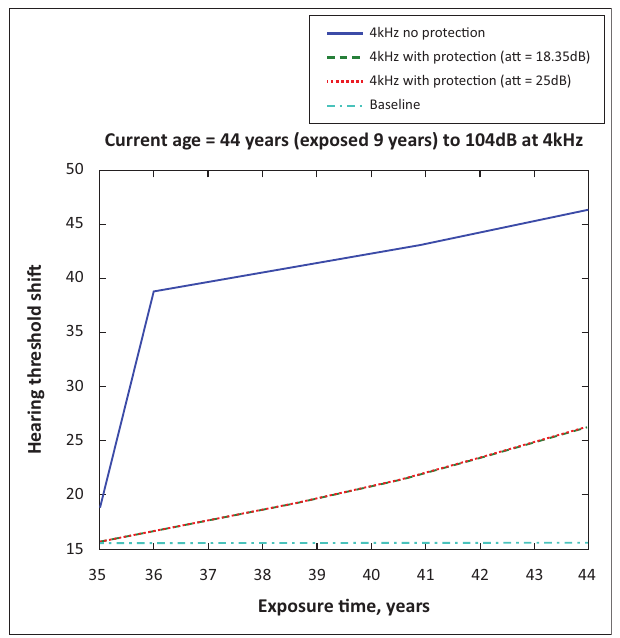
Source : Figure created using data from Moroe, N.F. (2018). Occupational noise-induced hearing loss in South African large scale mines: From policy formulation to implementation and monitoring . Doctoral thesis. Johannesburg: University of the Witwatersrand. FIGURE 16: Forty-four years old at 3000 Hz with exposure levels of 105 TABLE 2: Actual and predicted hearing using the feedback model.